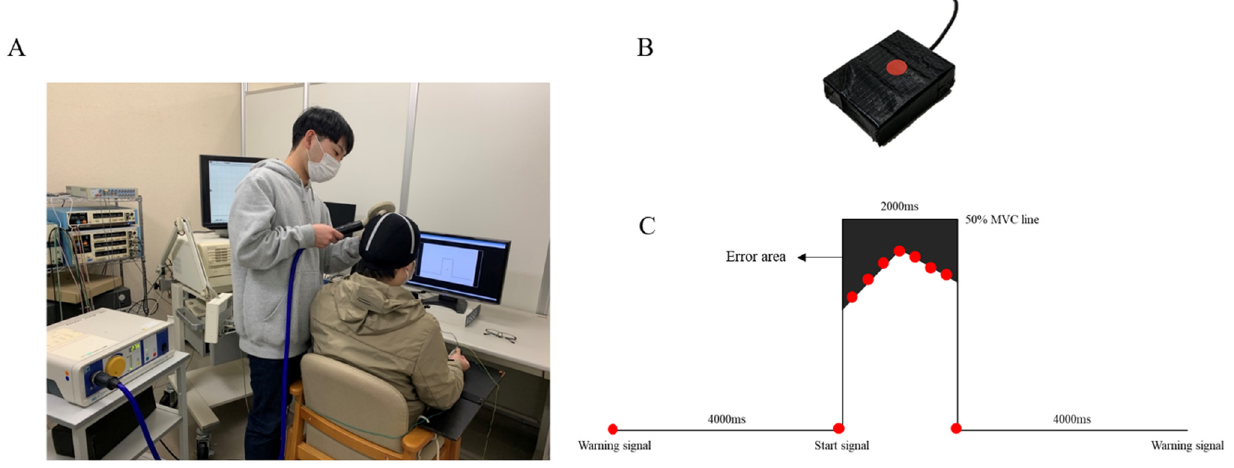
Figure 1. Experimental apparatus. ( A ) Experimental setup; ( B ) The strain sensor is placed in the middle of the prehension object; ( C ) Visuomotor Task; the tracking index is displayed on the computer screen in front of the participants. The red circle indicates the reaction marker.